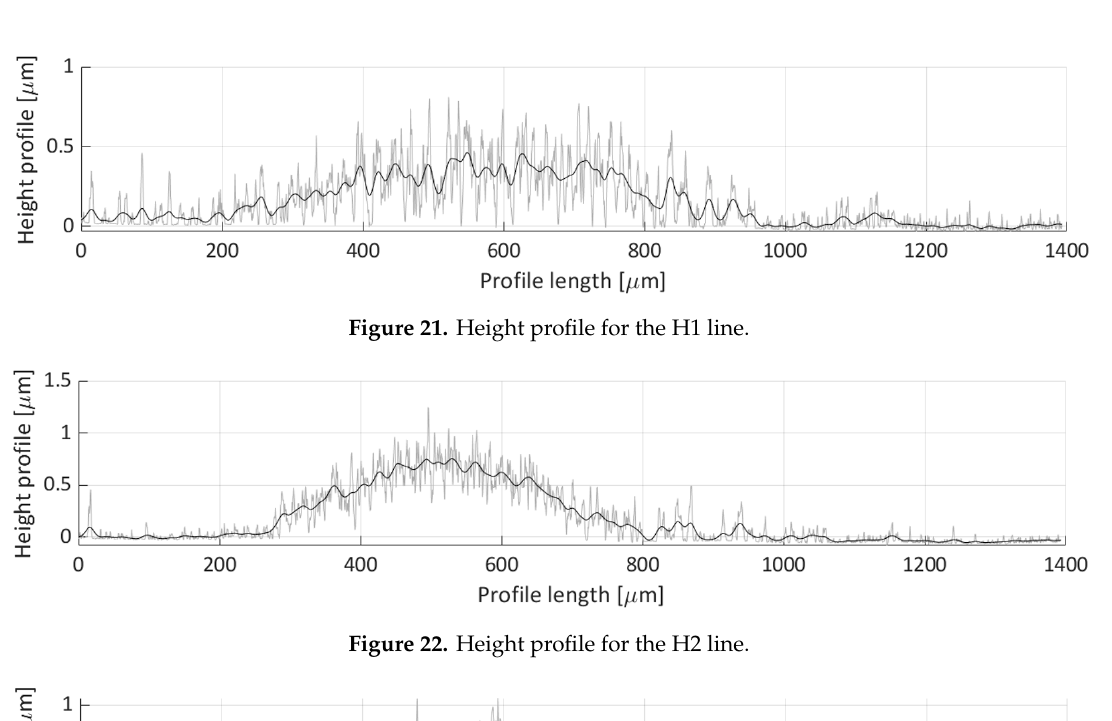
Figure 20. Height profile for the V2 line.